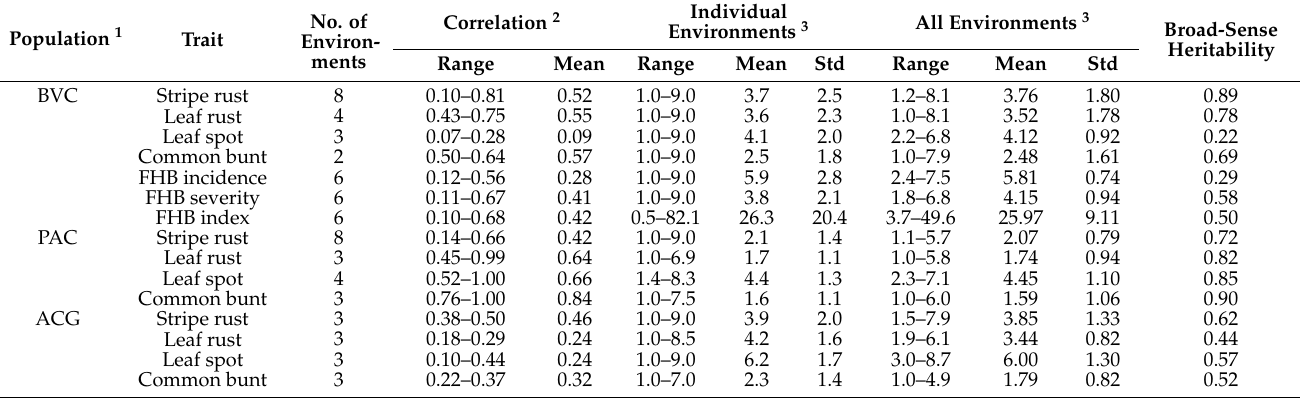
1 BVC: association mapping panel; PAC and ACG: recombinant inbred lines derived from a cross between Peace × Carberry, and Attila × CDC Go, respectively. 2 Within-trait phenotypic correlation coefficients between pairs of environments (site × year combinations). 3 Range: minimum and maximum scores; Std: standard deviation of the